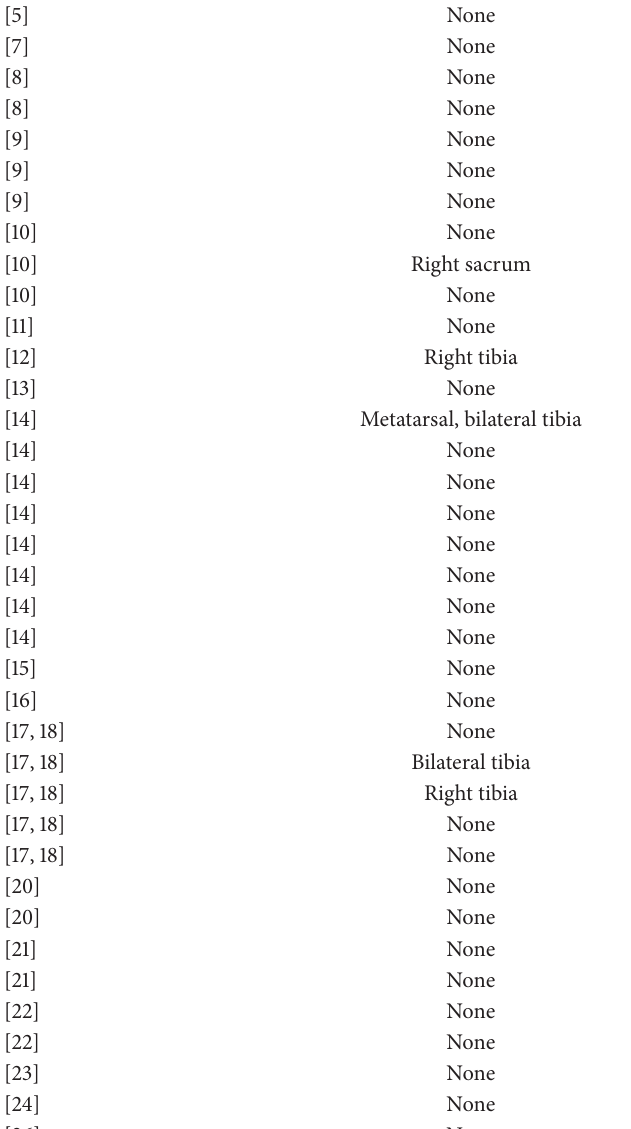
Table 3: Review of